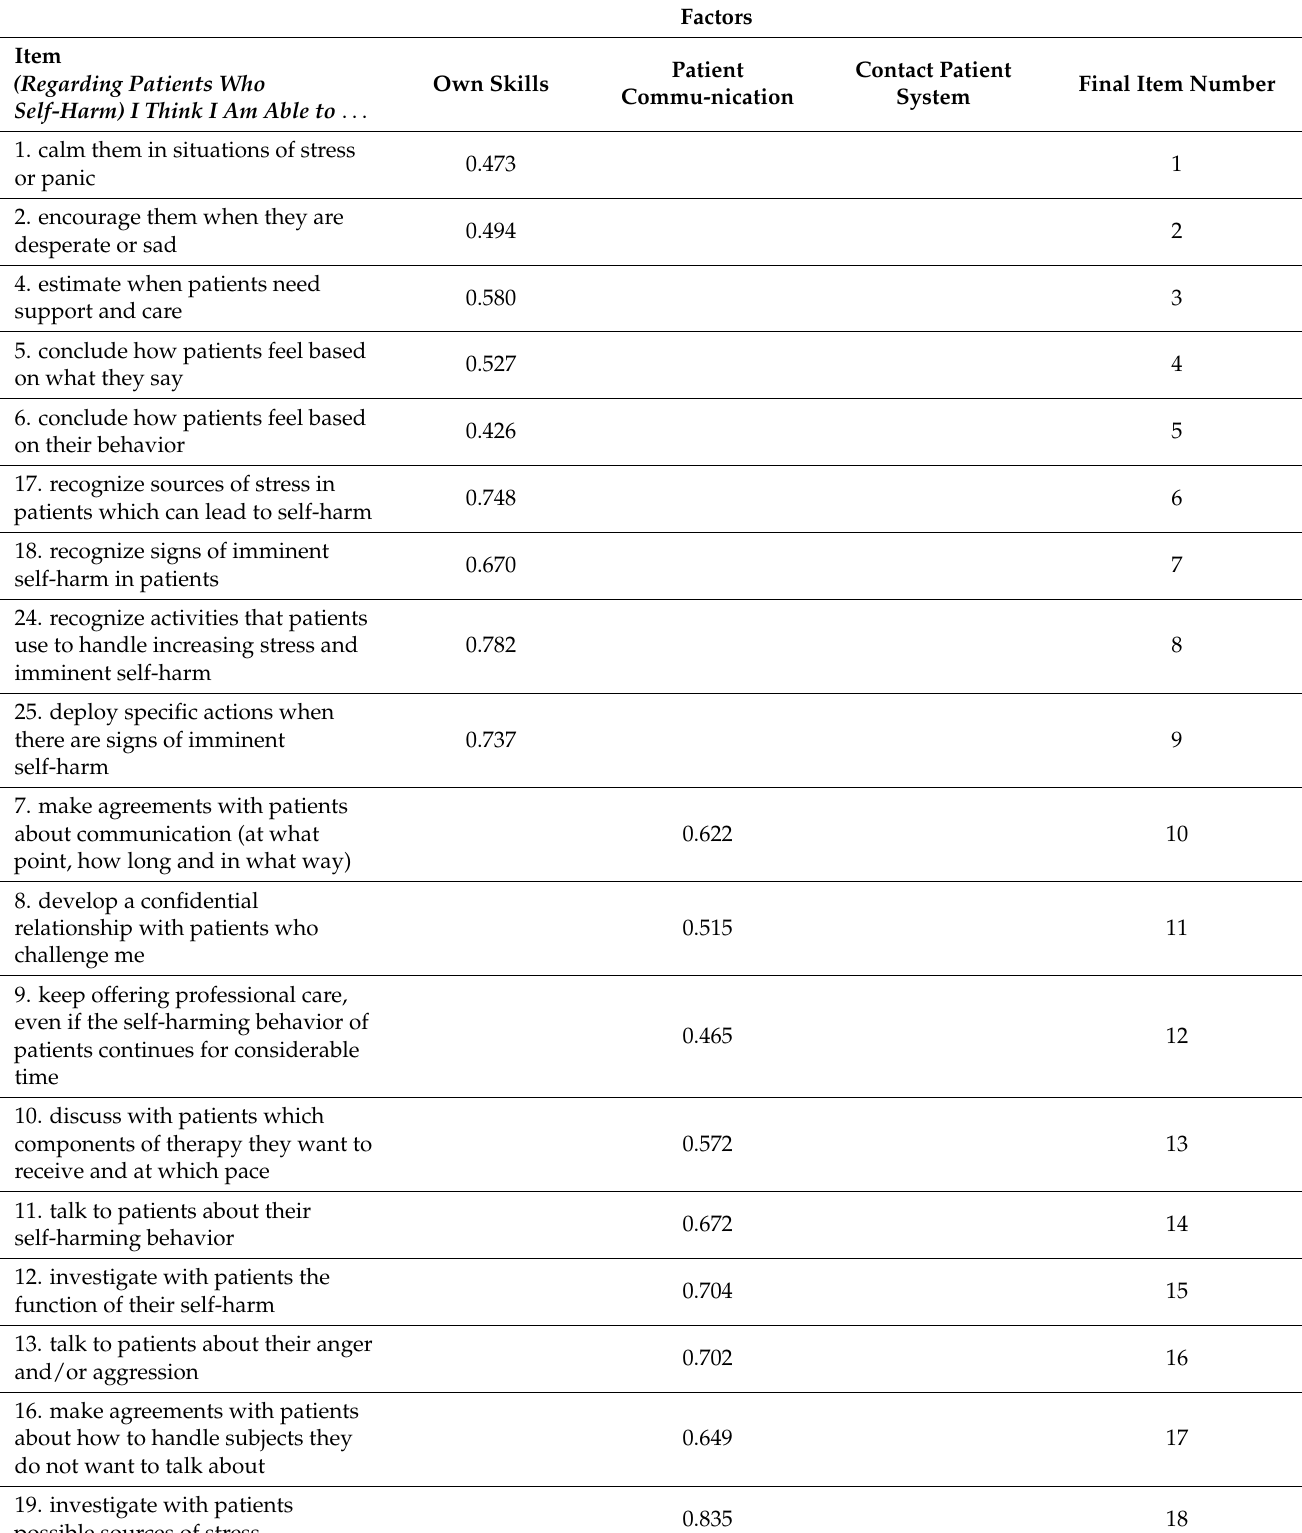
Table 3. Final version of the SEDSHQ: items and factor